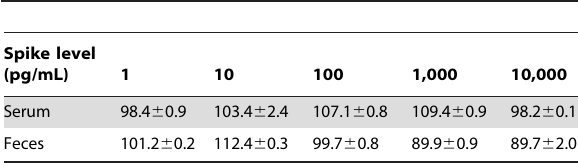
Data is the average of three replicates 6 one standard deviation.